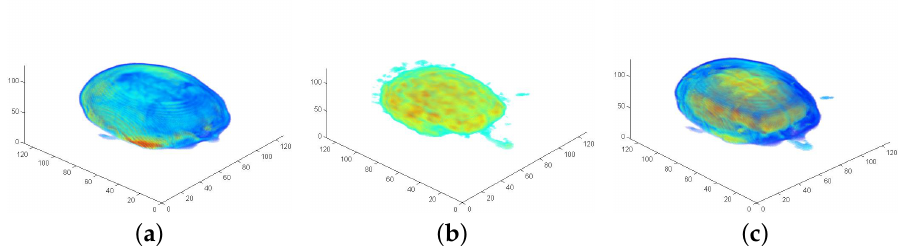
Figure 17. Result of LF-FMS registration. Scans are taken from the RIRE-repository, training001 . ( a ) MRT scan (T1). ( b ) PET scan. Compared to the T1 scan, the representation is fuzzy containing only partial content. ( c ) Resulting alignment of the MRT (T1) and the PET